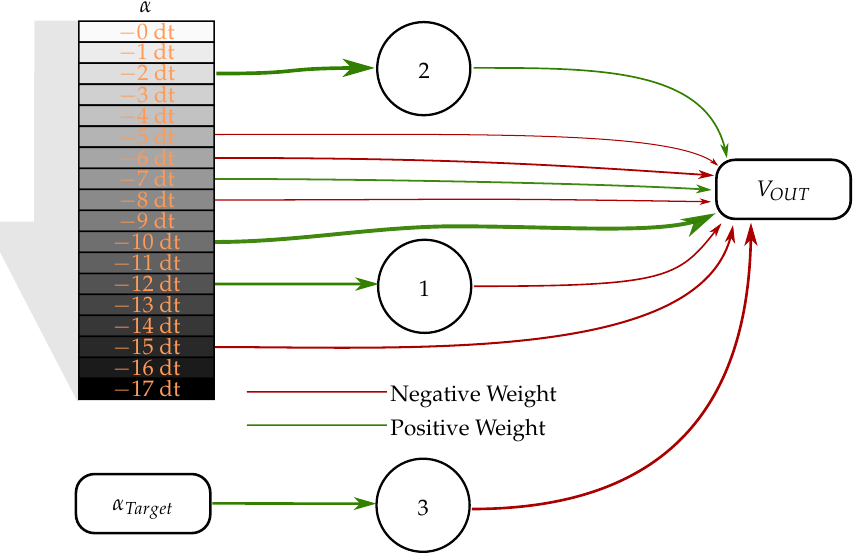
Figure 6. Structure of the best genome found; Line thickness represents weight strength; V OUT , 1, 2, 3 are different Neurons; Inactive Links and some inactive Inputs